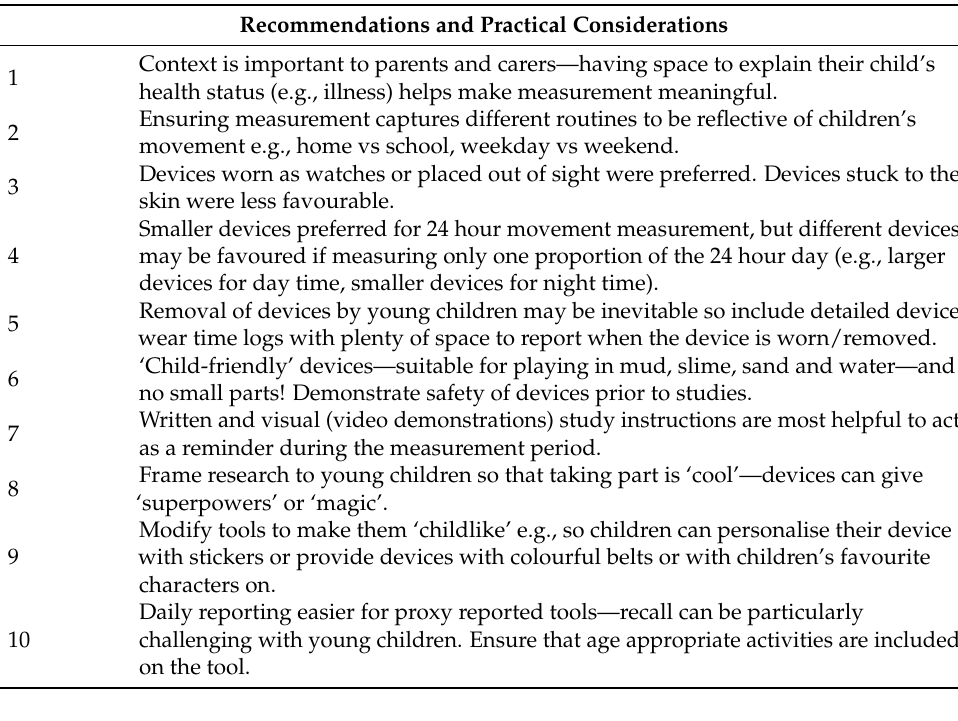
Table 2. Recommendations for measuring movement behaviour of pre-school